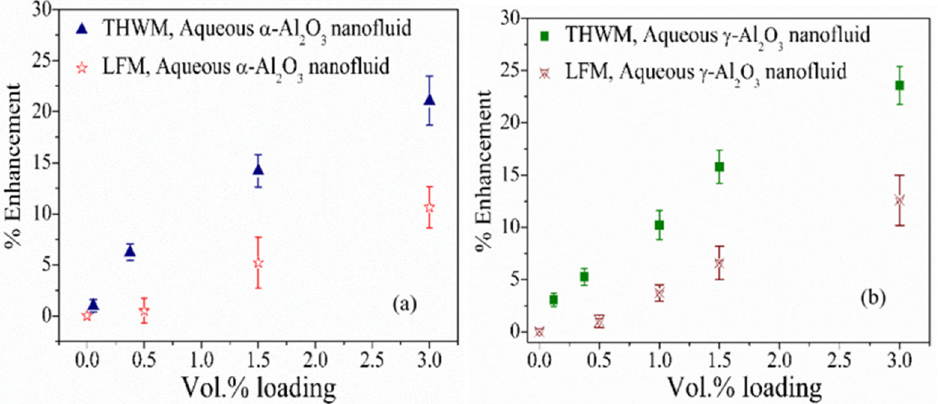
Figure 3. Thermal conductivity enhancement of ( a ) α -Al 2 O 3 and ( b ) γ -Al 2 O 3 nanofluids under increasing concentration using different measurement techniques [73].